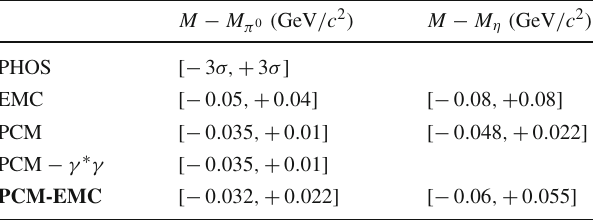
Fig. 4 Reconstructed η mass width (top) and position (bottom) versus p T for data and Monte Carlo simulation for PCM, EMC and PCM-EMC Table 2 Integration windows for the π 0 and η meson invariant mass distributions, where M π 0 and M η are the reconstructed mass positions from the fit, and M is the nominal mass of the respective